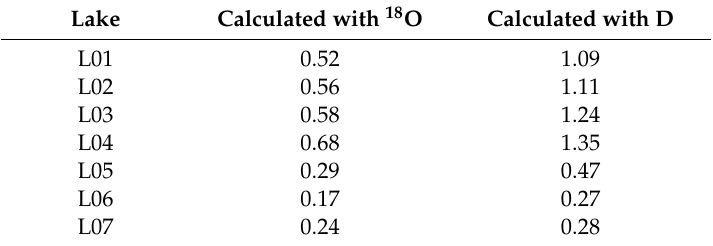
Table 5. E / I calculation